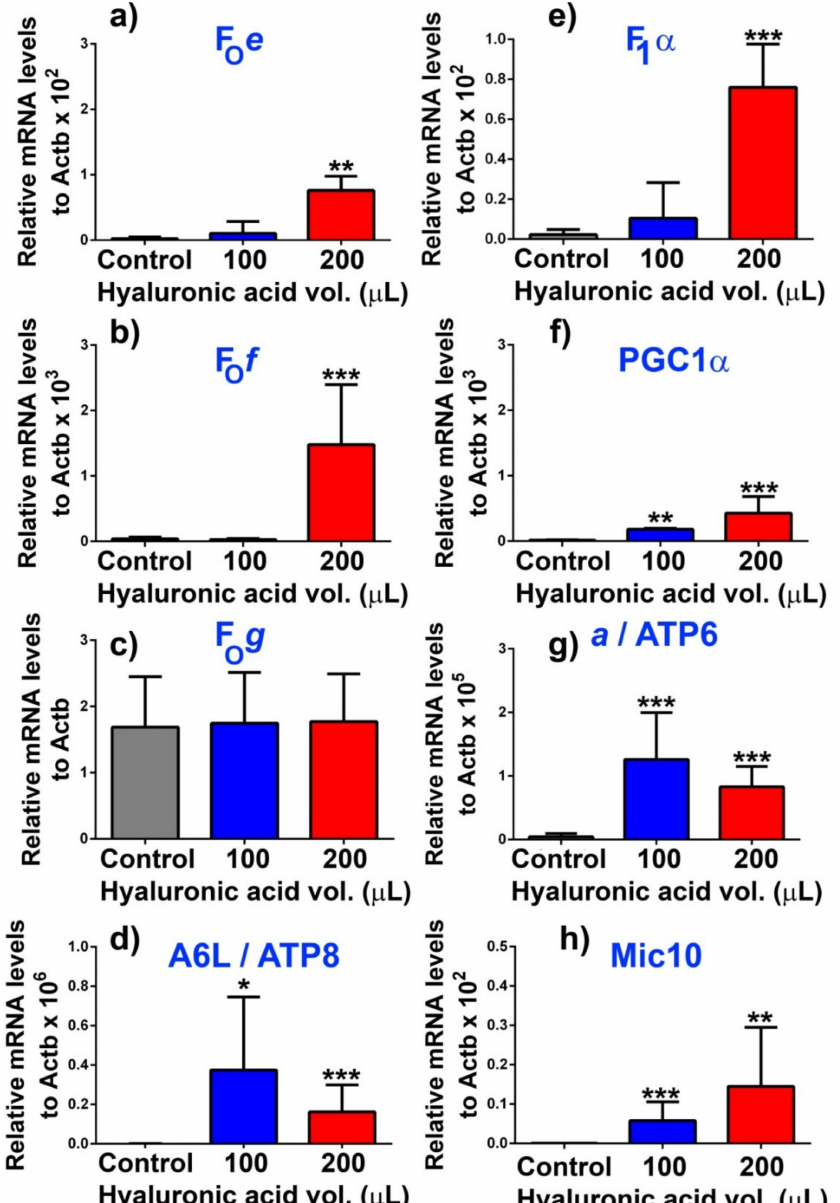
Figure 3. Upregulation of transcripts of other ATP synthase subunits ( a ) F O e, ( b ) F O f, ( c ) F O g, ( d ) A6L / ATP8, ( e ) F 1 α , and ( g ) ATP6 and ( f ) PGC1 α and ( h ) and Mic10 in pancreatic islets in mice—after two weeks of treatment with hyaluronic acid implants of the designated volumes. Data except in panel ( c ) are mutually significantly di ff erent ( N = n = 5 mice per group): *** p < 0.001; ** p < 0.05; * p < 0.1 (with exception of controls vs. 100 µ l in panels ( a , b , e